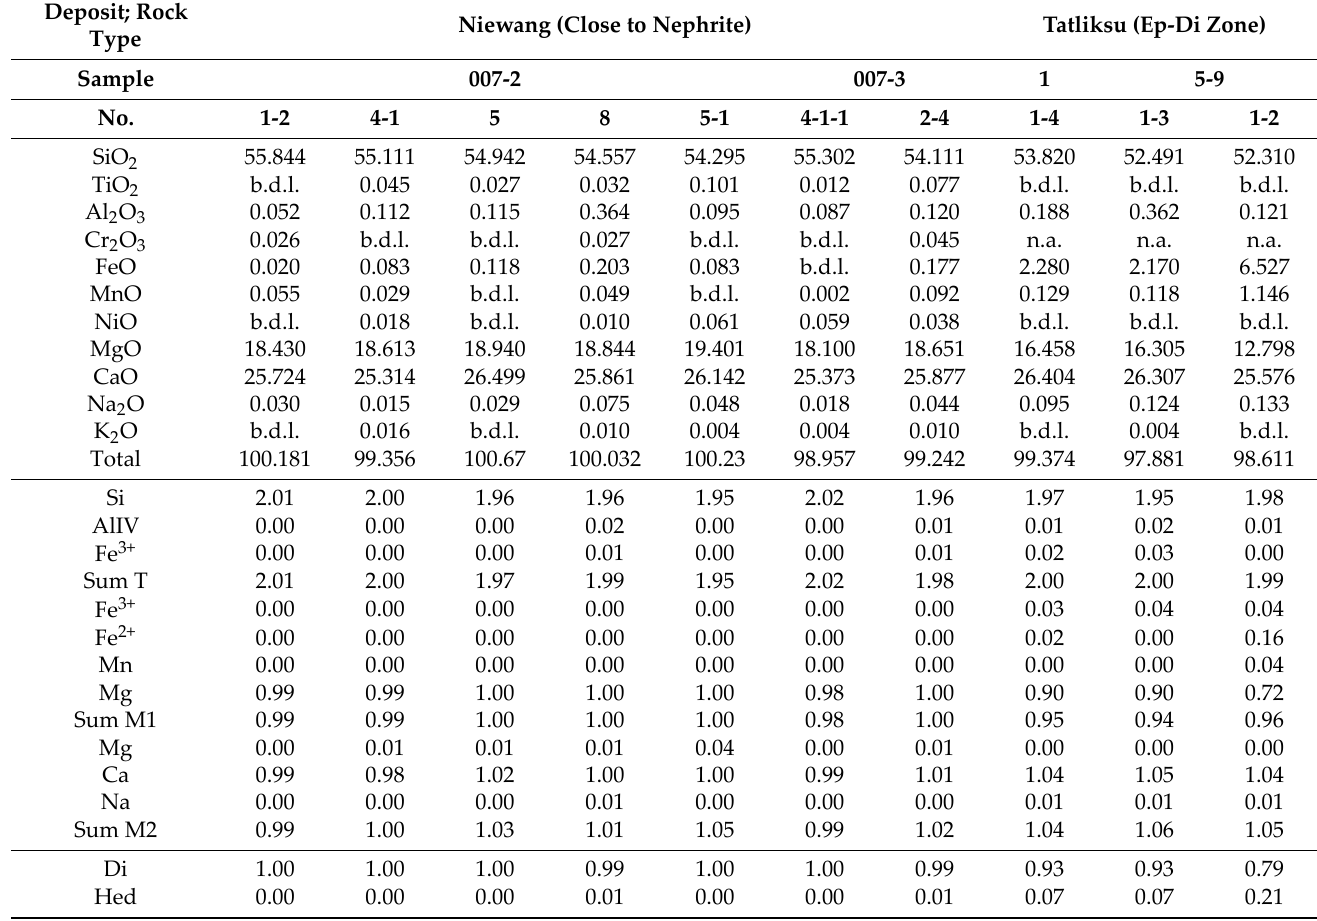
Table 1. Chemical compositions of diopside from the studied nephrite deposits (wt.%) *.